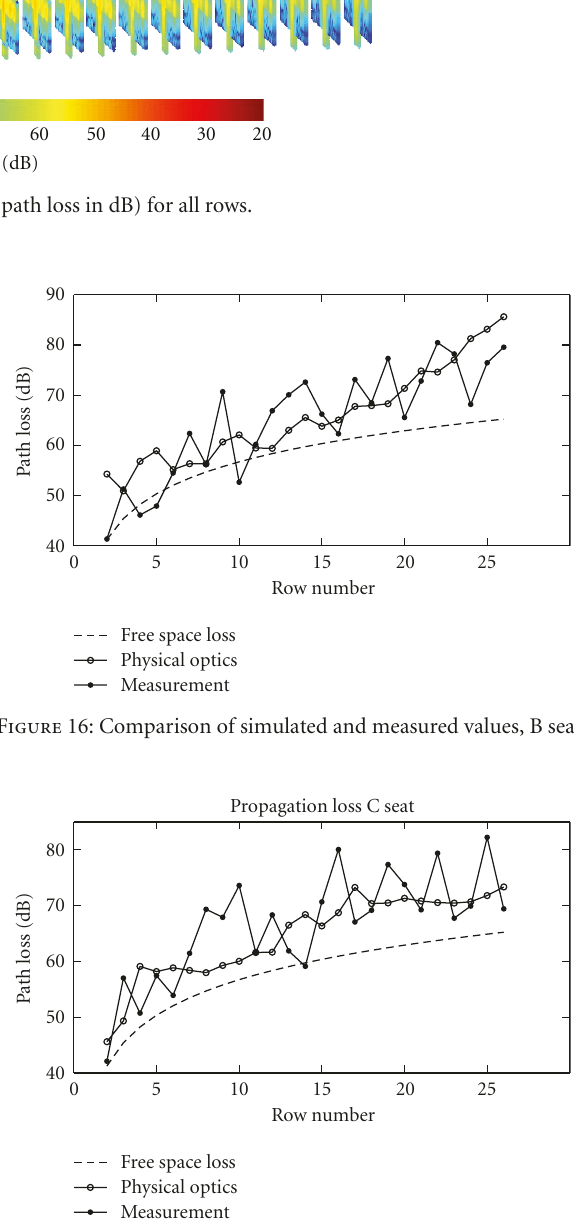
Figure 15: Comparison of simulated and measured values, A seat.